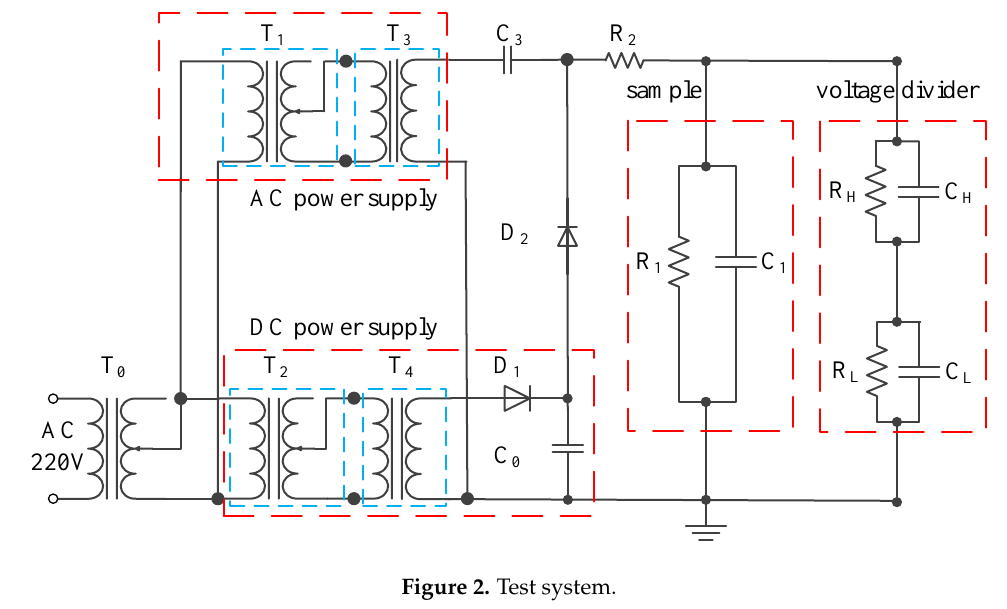
Figure 2. Test system.